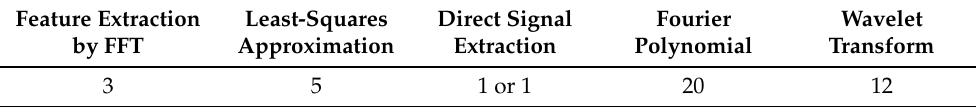
Table 2. Number of features collected in unit window for each feature extraction method. Feature